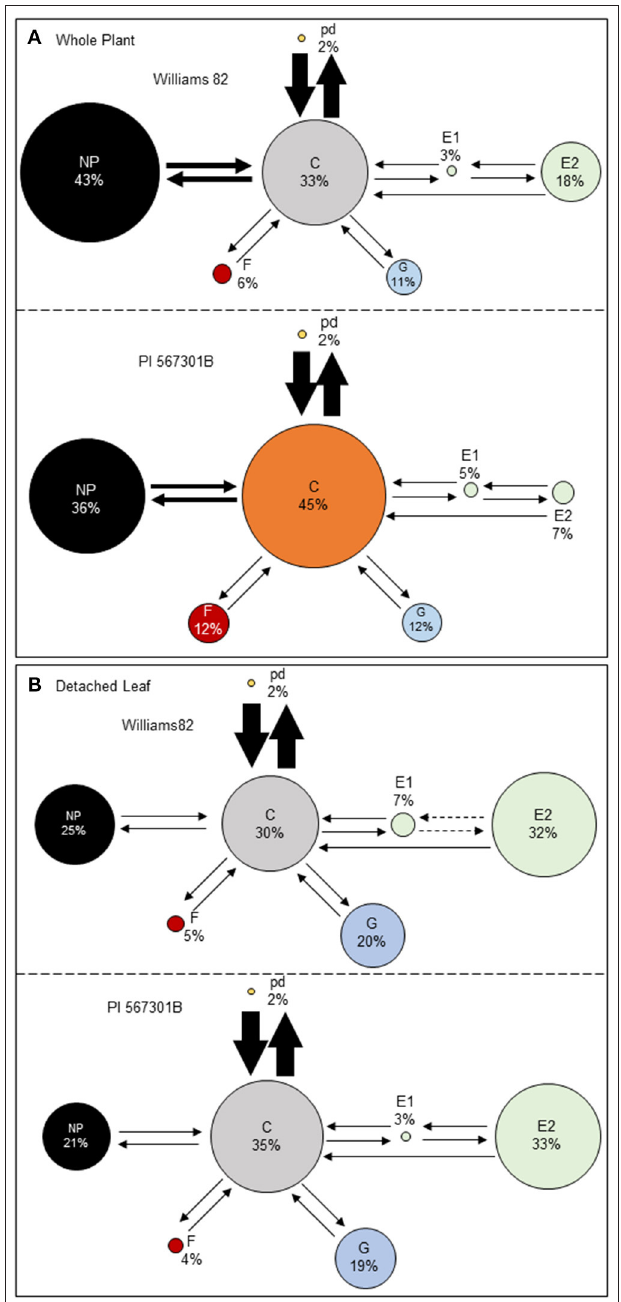
FIGURE 2 | Aphid feeding behaviors on (A) whole plants and (B) detached leaves of Williams 82 and PI 563701B. The behavioral kinetogram shows aphid feeding behavior with arrows representing transitions and arrow thickness proportional to frequency. The size of the circles represents the percentage of time aphids spent in each of the waveforms: non-probing (NP), probing/pathway phase (C), potential drops (pd), derailed stylet (F), xylem phase (G), phloem salivation (E1), and phloem ingestion (E2). The data summarized are the summed counts from all aphids in each treatment. The durations or circle areas with different colors and dotted arrows represent parameters that are significantly